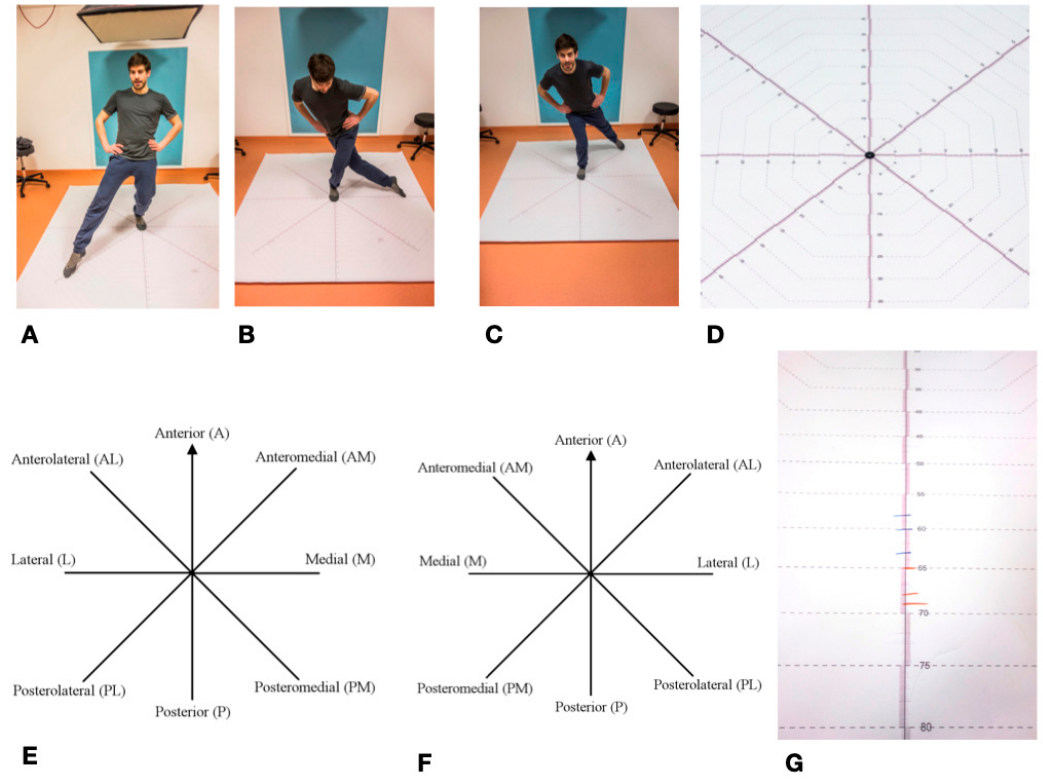
Figure 8. Star Excursion Balance Test—SEBT: ( A – C ) Mainstay left, towards Posterolateral; Lateral; and, Posteromedial; ( D ) SEBT detailed view of measuring cross; ( E ) SEBT stand on the left; ( F ) SEBT mainstay on the right; and, ( G ) Length marking as an example; blue = right leg; red = left leg.